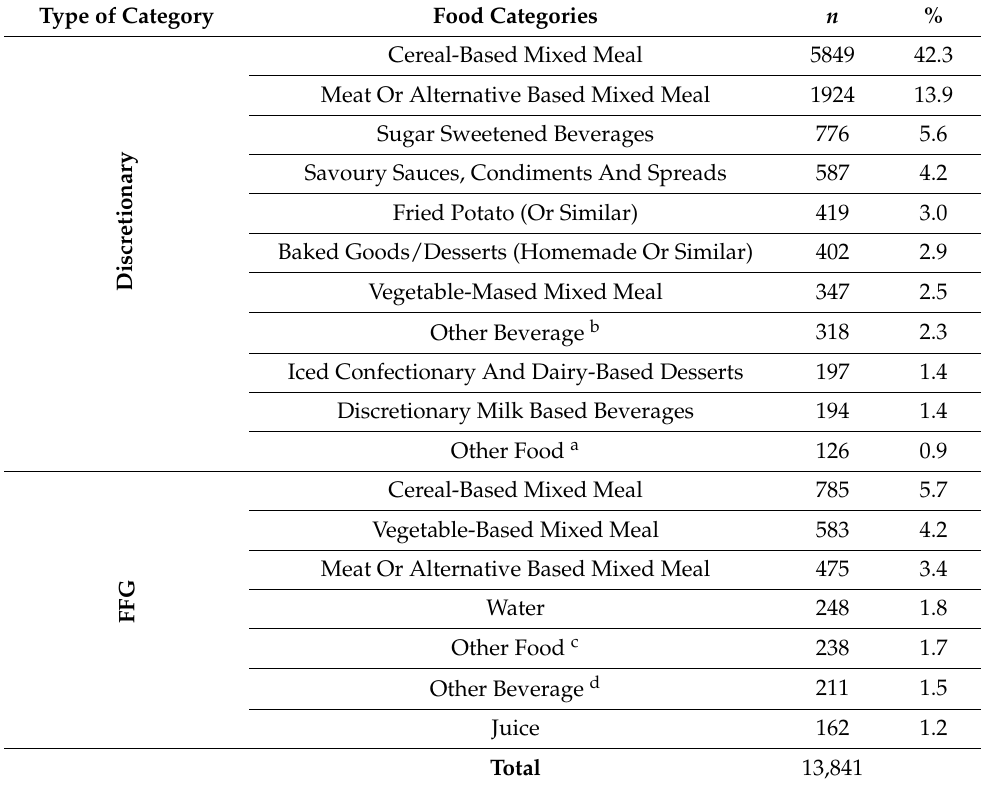
independent takeaways. Categories are sorted in descending